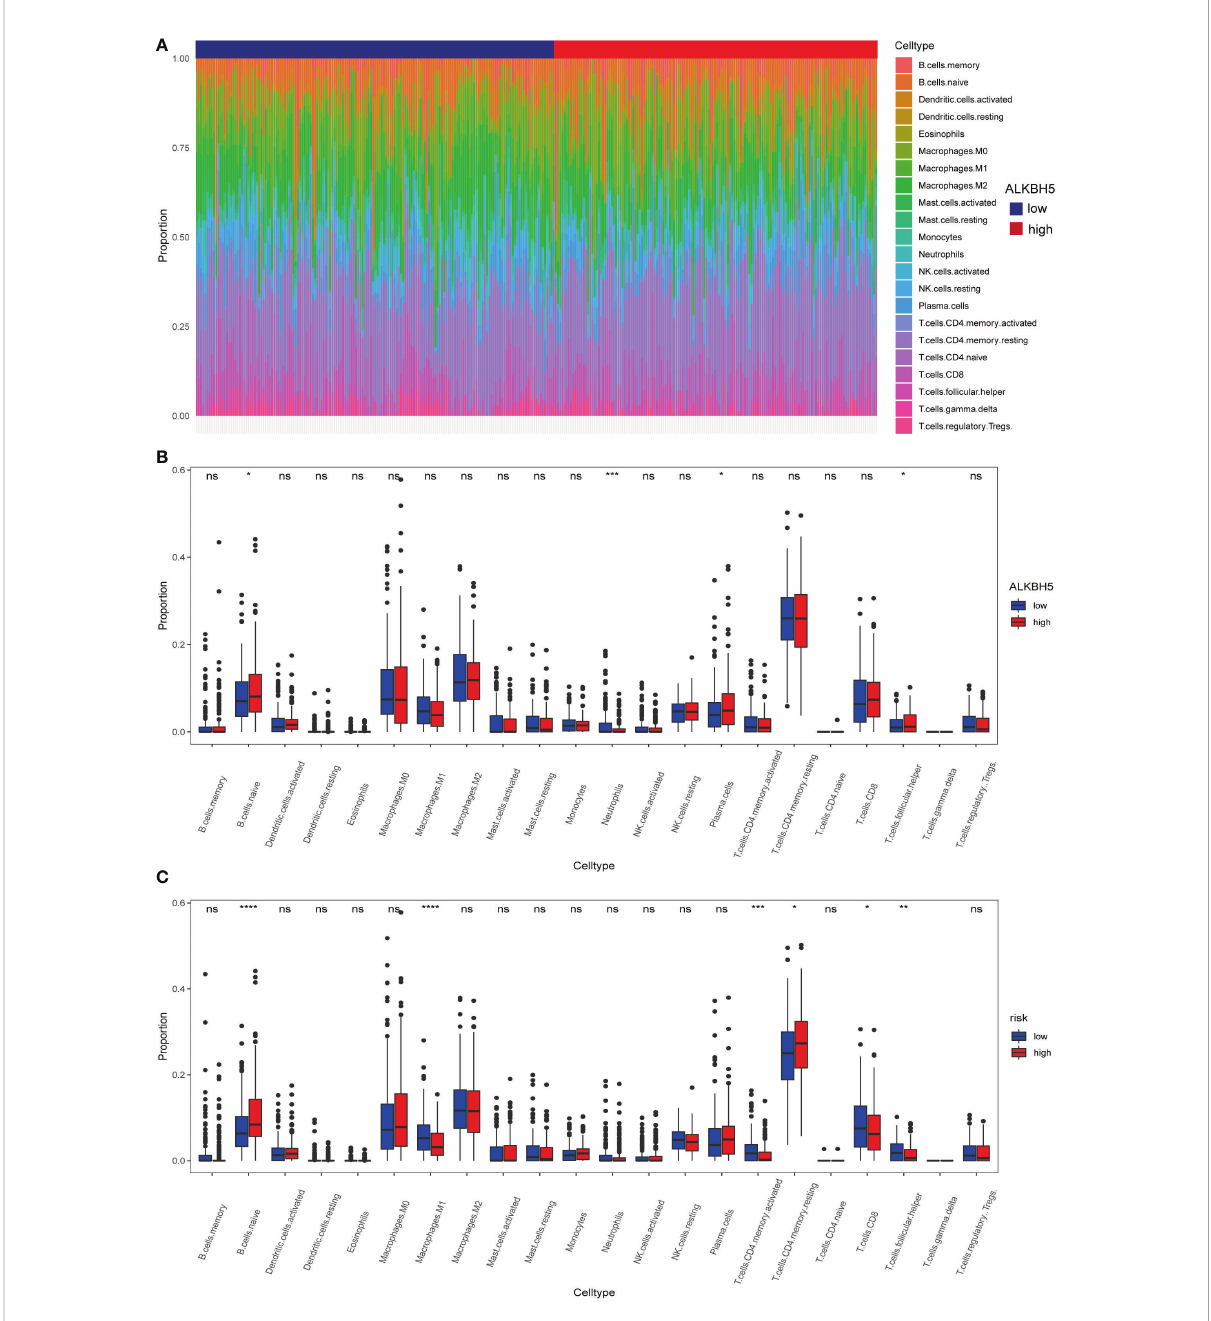
FIGURE 7 Different immune cells in fi ltration of ALKBH5 -low/high subgroups and risk-low/high subgroups. (A) Relative proportions of 22 immune cells ’ in fi ltration in each GC sample according to the expression of ALKBH5 . (B) Comparison of 22 immune cell proportions in fi ltrated in GC samples between ALKBH5 -low and ALKBH5 -high subgroups in the whole dataset. (C) Comparison of 22 immune cell proportions in fi ltrated in GC samples between low-risk and high-risk subgroups in the whole dataset. ns, non-signi fi cance, *P<0.05, **P < 0.01, ***P < 0.001, ****P <